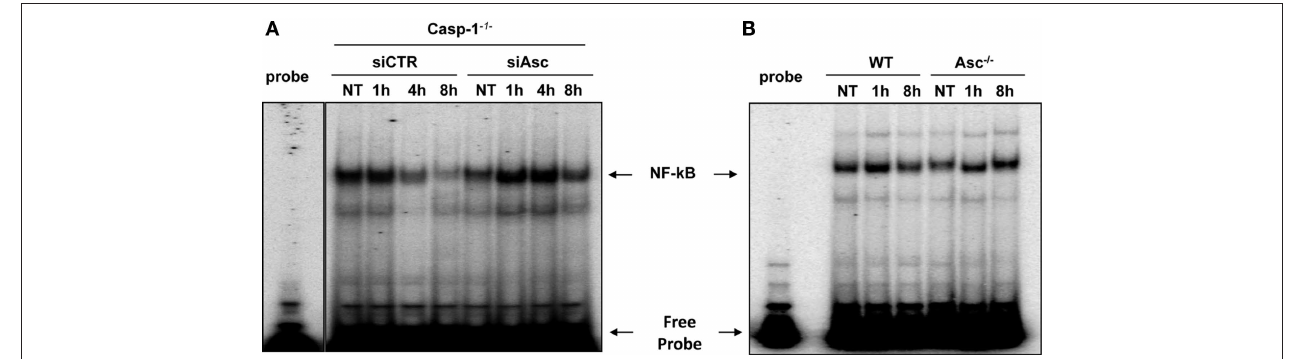
Figure 2 | Asc hinders the activation of NF- κ B induced by L. pneumophila . (A) Caspase-1 − / − (casp-1 −/− ) macrophages were transfected with Asc specific siRNA (siAsc) or control siRNA (siCTR) and 48 h after transfection cells were infected or not (NT) with L. pneumophila (Leg) at MOI = 0.5 for 1, 4, and 8 h.